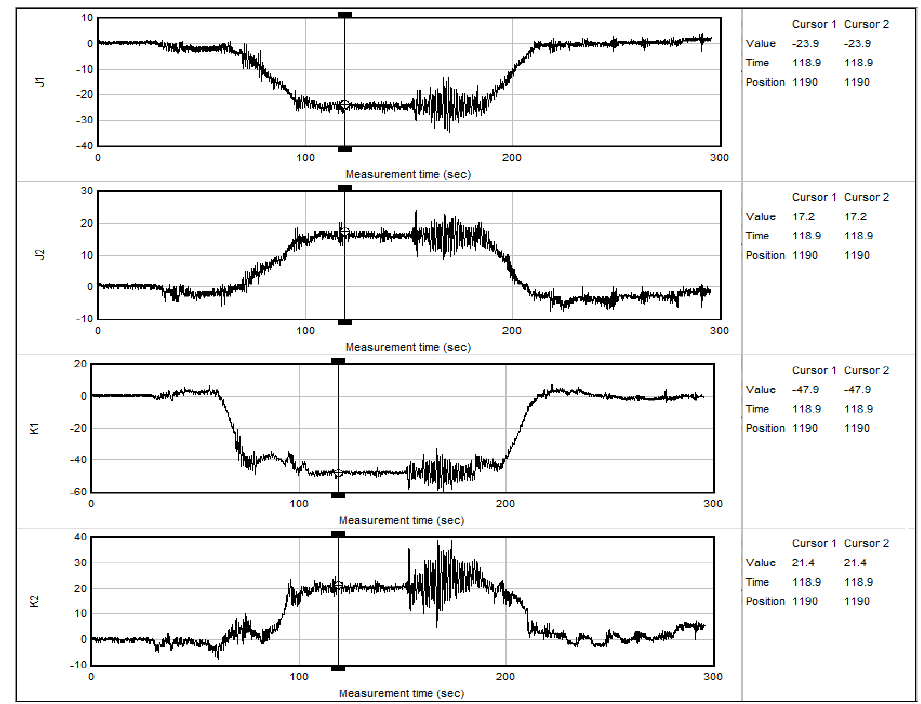
Figure 20. Stress test results graph.